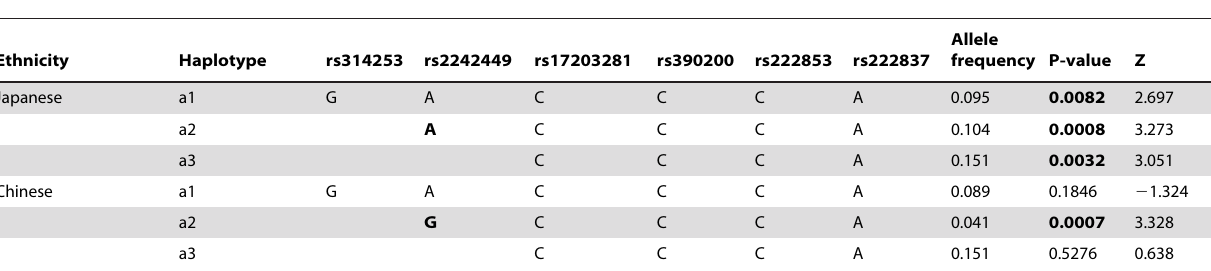
Table 4. DLG4 haplotype comparison in Japanese and Chinese schizophrenia pedigree samples.